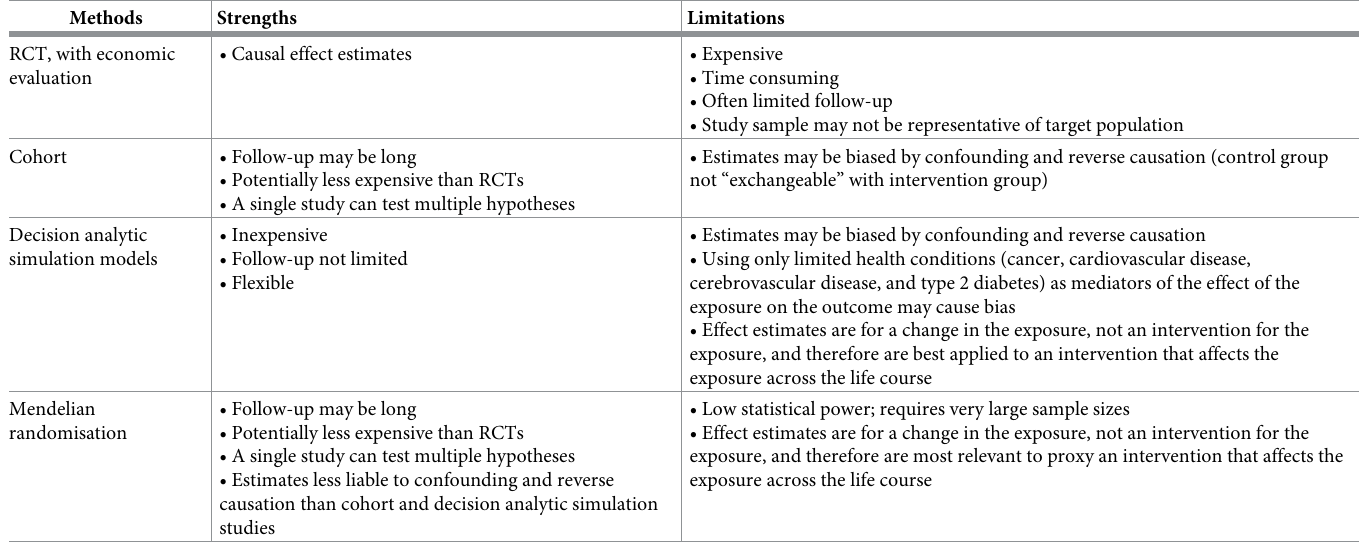
Table 1. AU : PerPLOSstyle ; boxescannotbecell (cid:0) based ; eitherreformatastextorchangetotable : Hence ; Box 1 anditscitationinthetexthavebeenchangedtoTable 1 : The strengths and limitations of different methods to estimate the cost-effectiveness of interventions.